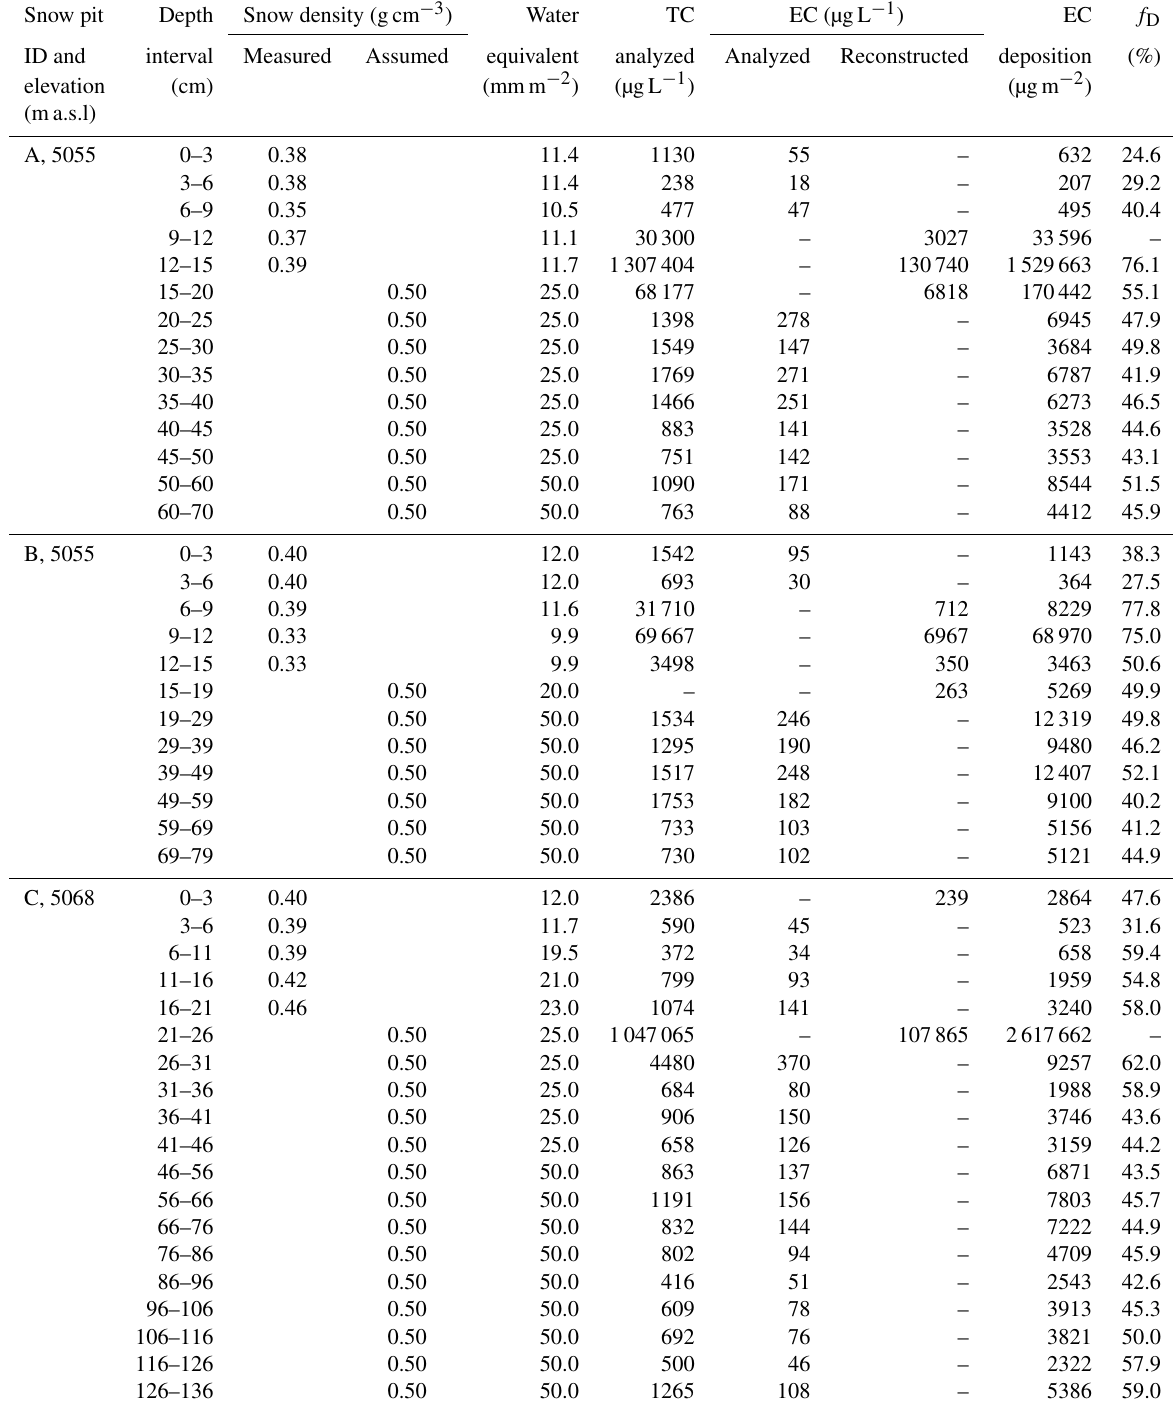
Table 1. Snow pit details from the Sunderdhunga Valley. Durga Kot glacier snow pits are A and B, while C–F are from the Bhanolti glacier. TC: total